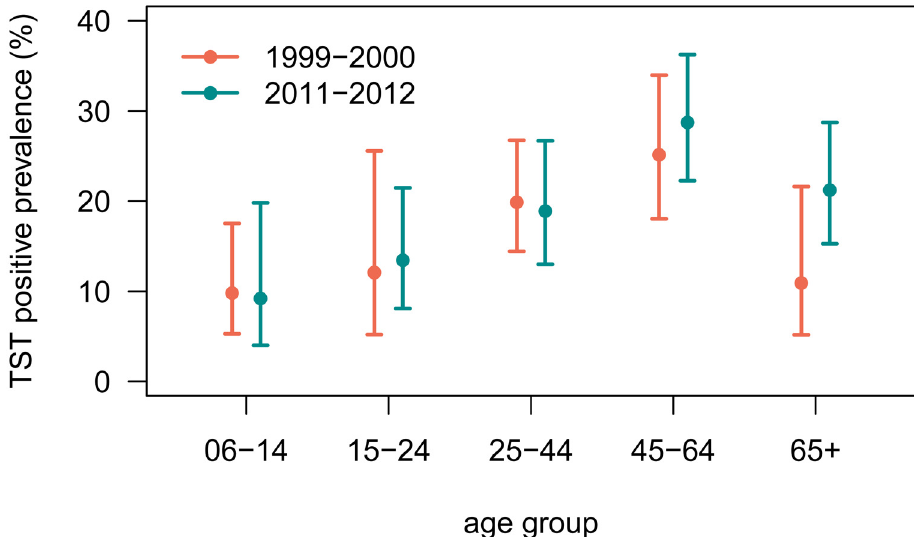
Fig 3. Tuberculin skin test positive prevalence estimates from the civilian, noninstitutionalized foreign-born population aged 6 years or older, by age group. The orange points represent 1999 – 2000 prevalence estimates and the teal points represent 2011 – 2012 estimates. The vertical lines represent 95% confidence intervals.